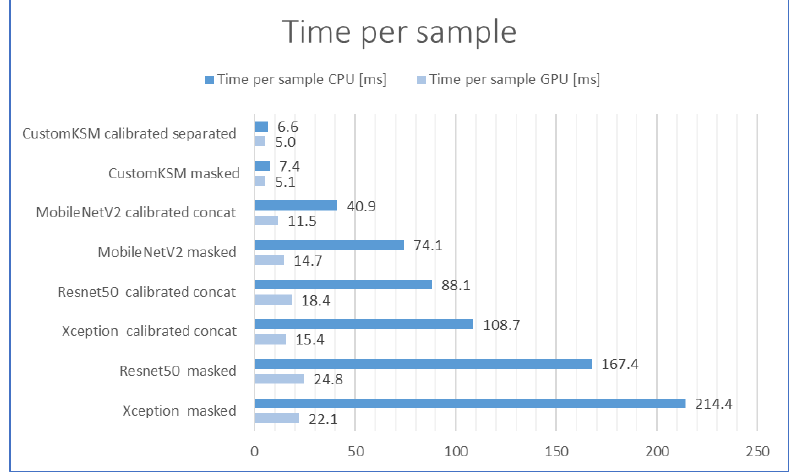
Figure 11. Inference times for the tested models in milliseconds, the lower the better.